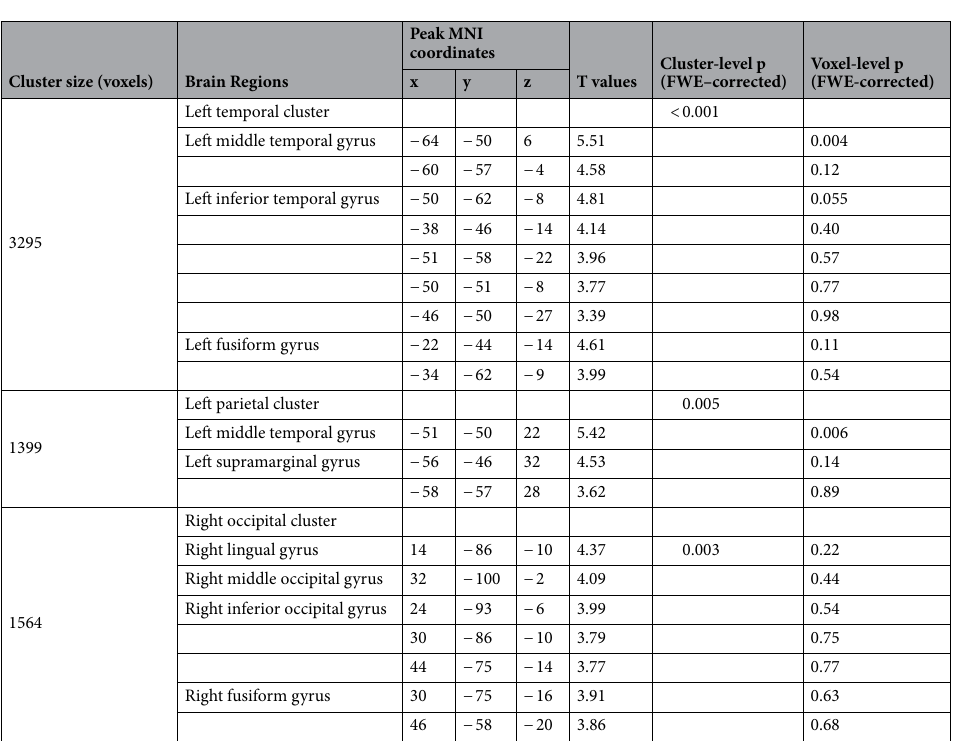
Table 2. Regions of significantly lower GMV in LLD detected in the whole-brain GMV analysis. Peak coordinates were local maxima more than 10 mm apart.